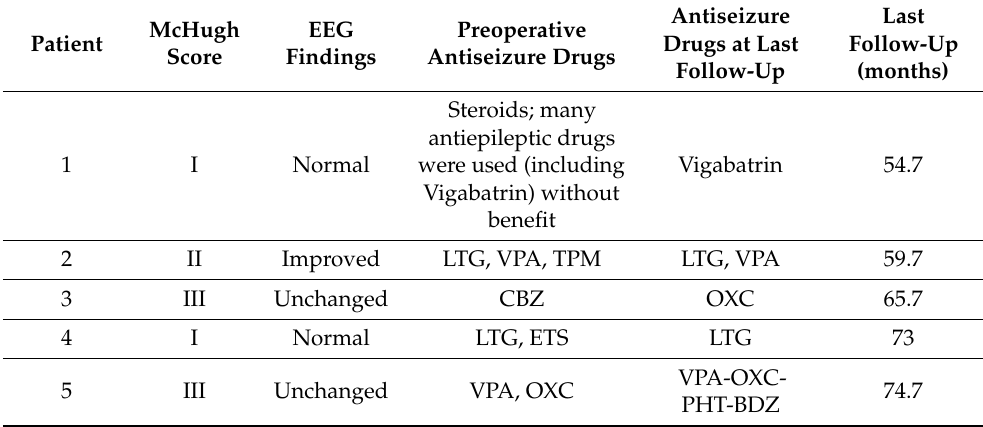
Table 3. McHugh score, EEG findings at last follow-up and anti-epileptic drug therapy modifications.